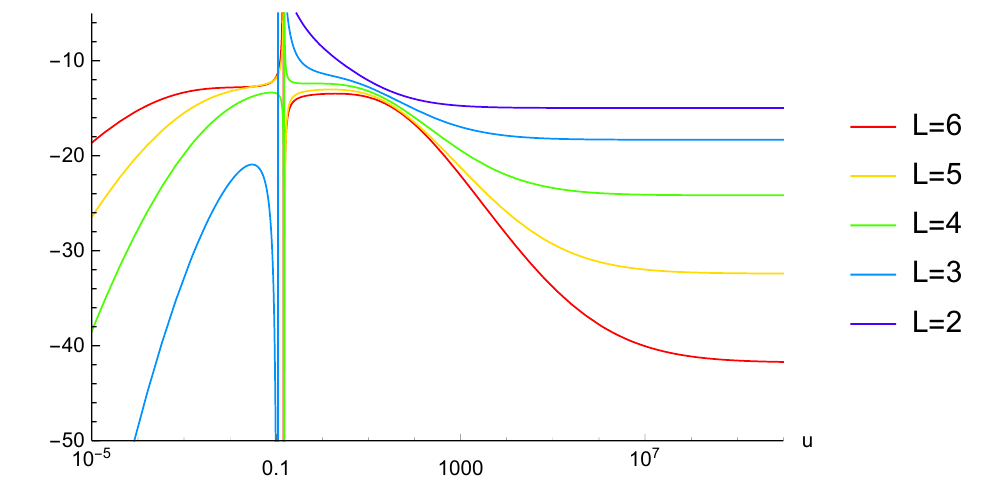
Figure 1 . E ( L ) ( u; u; 1) =E ( L (cid:0) 1) ( u; u; 1) evaluated at successive loop orders. As there are